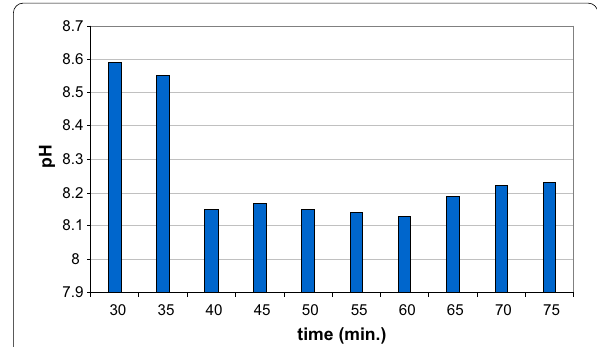
Fig. 13 pH versus time (30 min. up to 75 min), by using brackish groundwater in case of closed cycle at flow rate of 52.16 l/min